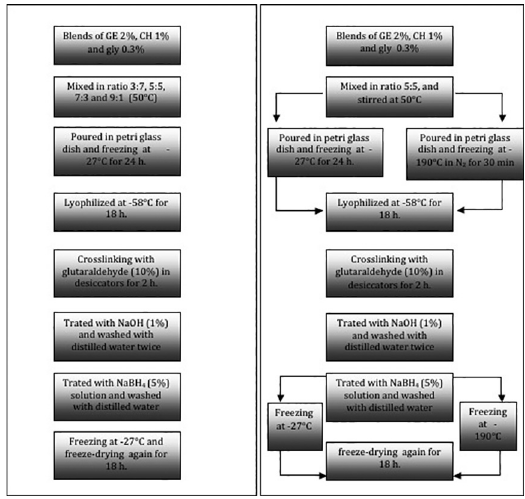
Figure 1: Diagram of the steps of obtaining scaffolds, left (effect of the solid concentration) and right (effect of freezing rate). To crosslinking the GE:CH, the obtained sponge was placed inside desiccators containing glutaraldehyde (10%) in 200 ml ethanol (90%) during 2 h. Then, the sponge was immersed in NaOH solution (1%) and washed with distilled water twice, and treated with a NaBH (5% w/v) solution to 4 block residual aldehyde groups. After that, the scaffolds were conveniently washed with distilled water and re-submitted to freezing, followed by the second freeze-drying for 18 h. The best composition was selected for further characterization; the effect of freezing